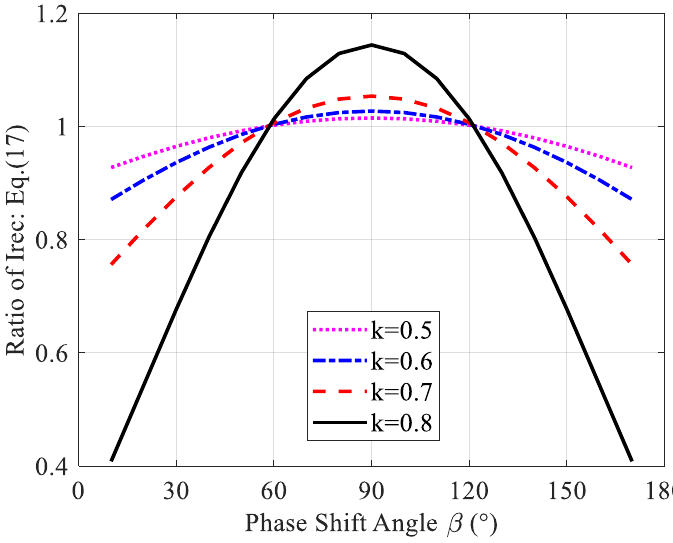
Figure 5. Ratio of I REC in (17) varying with β .